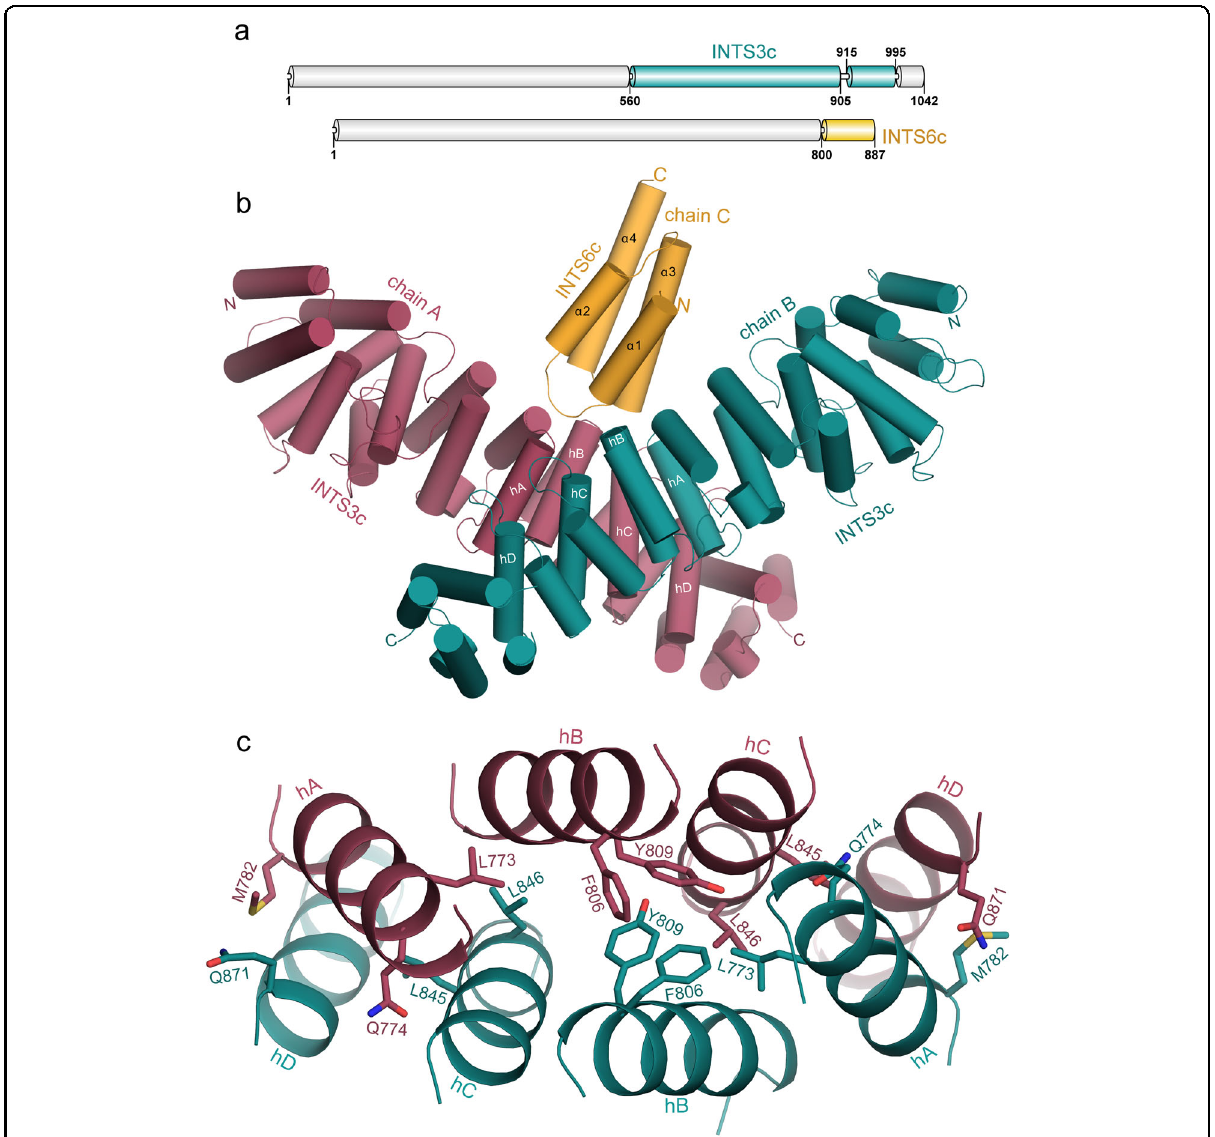
Fig. 1 Structure of the INTS3c/INTS6c complex. a Schematic representation of human INTS3 and INTS6. b Crystal structure of the INTS3c/INTS6c complex. c The dimer interface of INTS3c. The central core of the dimeric interface of INTS3c is made up of helical segments: hA, hB, hC, and hD. For simplicity of viewing, only few interactions involving Leu773, Gln774, Met782, Phe806, Tyr809, Leu845, Leu846, Gln871, and their dyad symmetry mates are